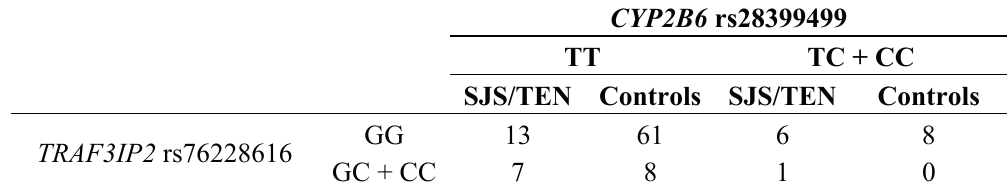
Table 4. Interaction among rs28399499 ( CYP2B6 ), rs76228616 ( TRAF3IP2 ) and SJS/TEN: three way contingency table analysis by log-linear